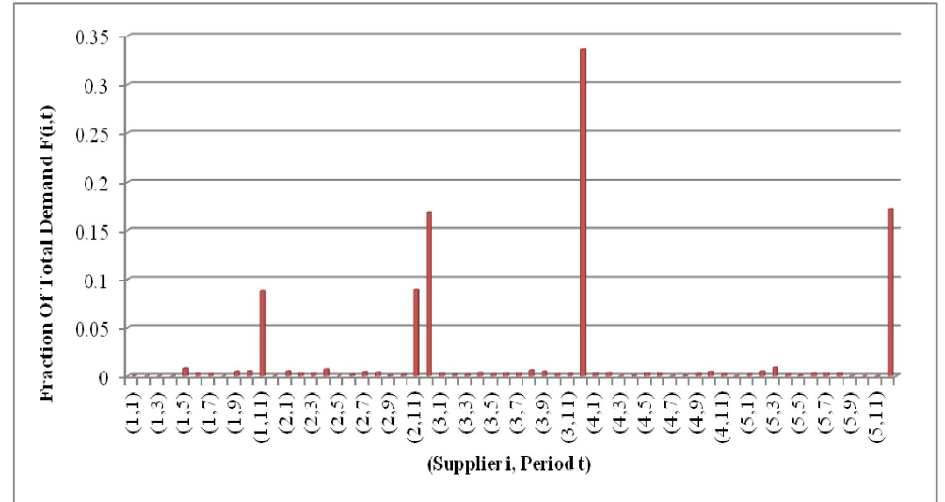
Figure 9. Values of supply portfolio variables for α=75% in a large size test